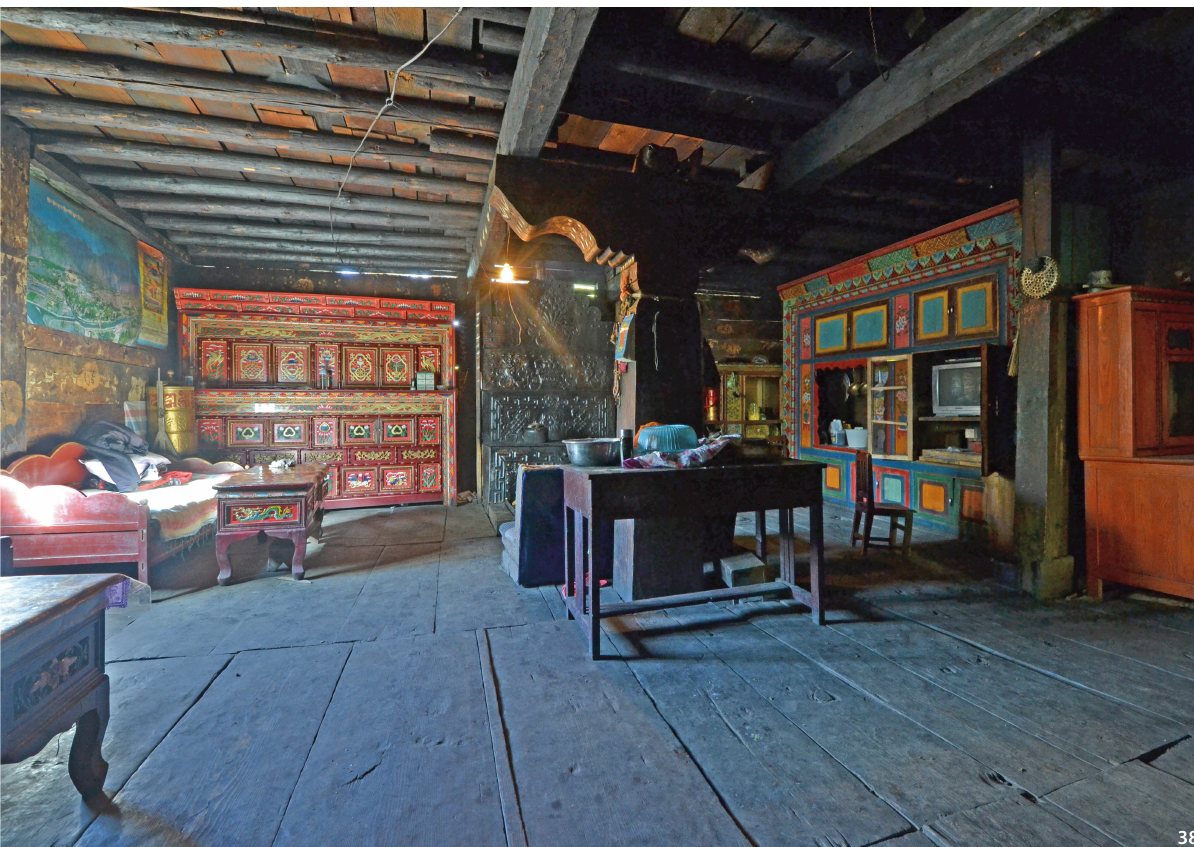
Figure 38 Interior of the main living room/ kitchen of the farmhouse in Pome (Source: the authors).